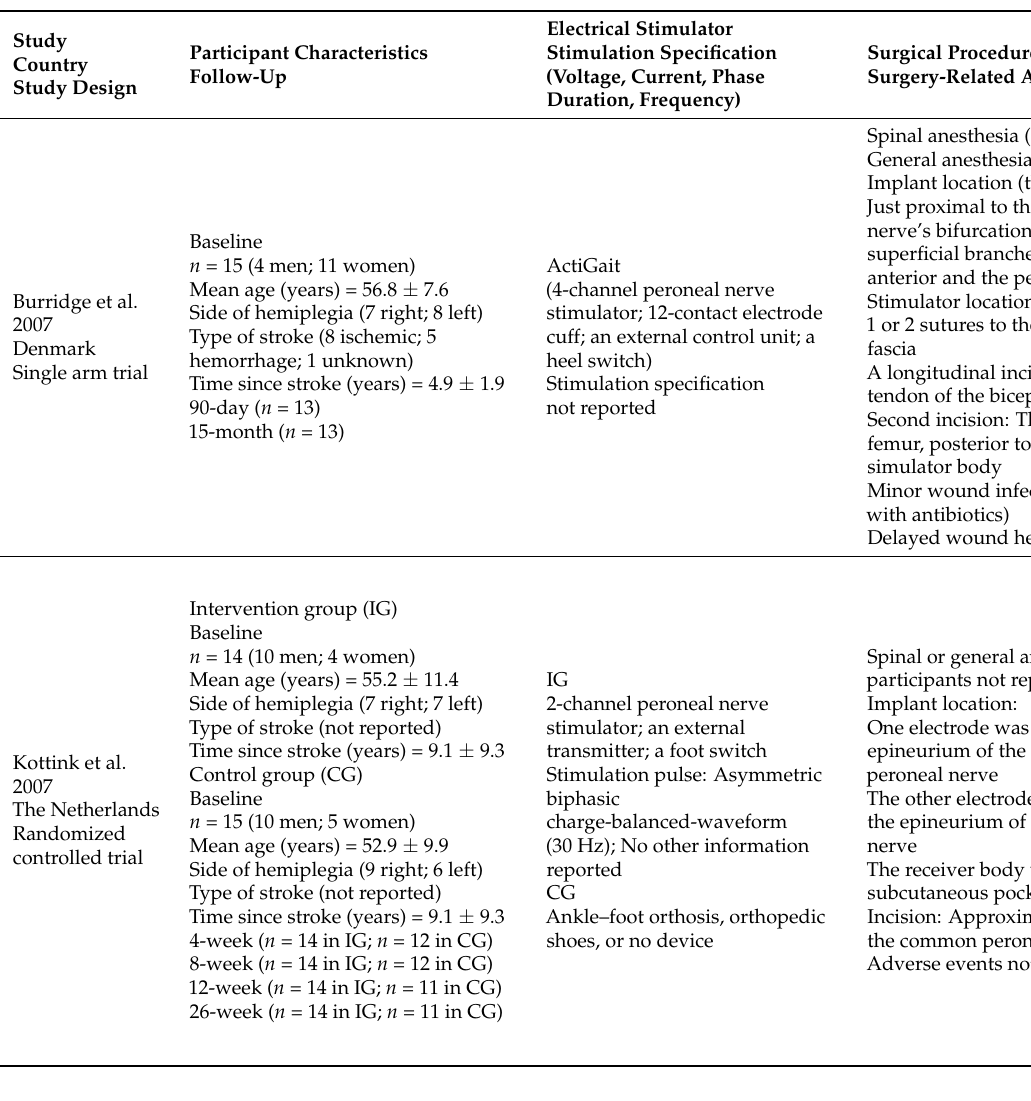
Table 2. Characteristics of studies included for full